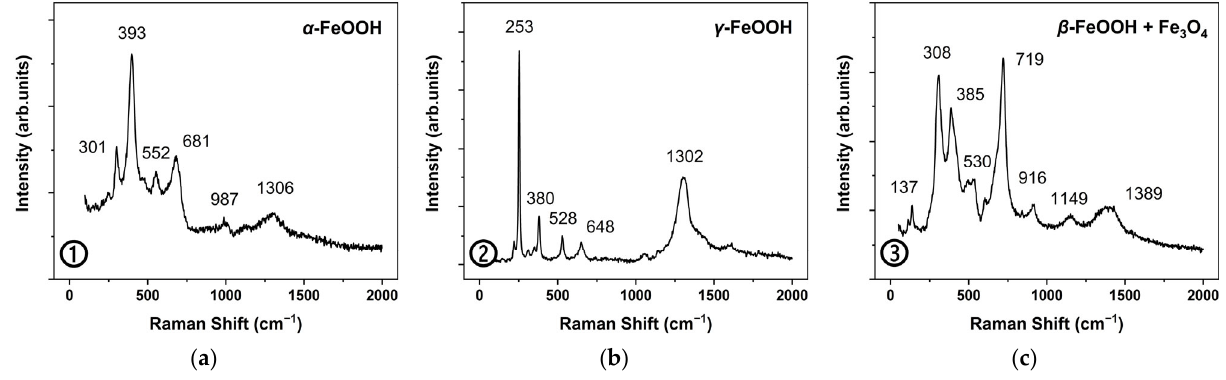
Figure 5. Micro-Raman diagrams of original rust area A. Testing points 1–3 ( a – c ) in Figure 3a.